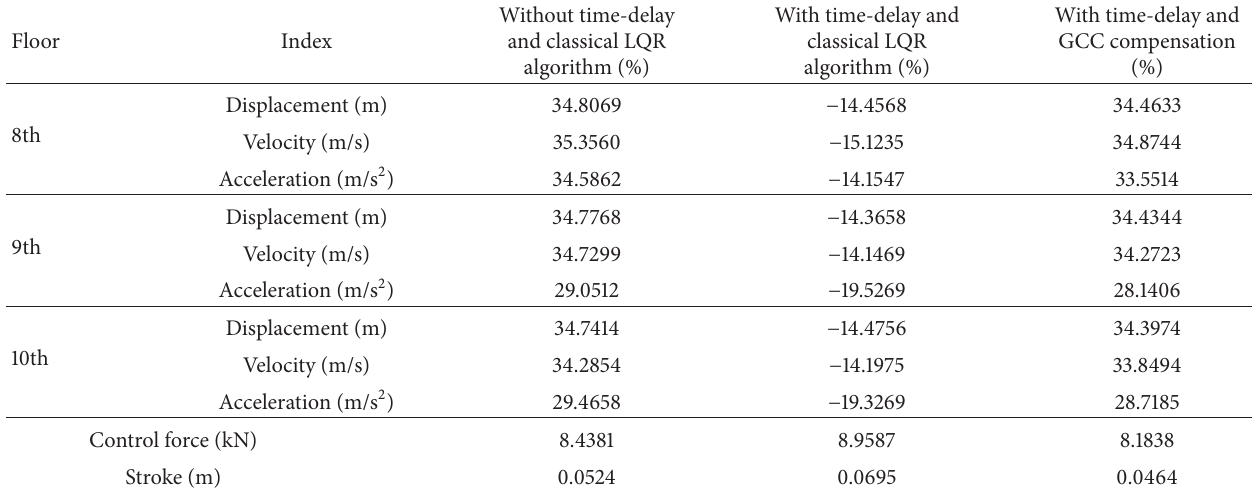
Table 5: Comparison of control effects (%) and AMD parameters of different control